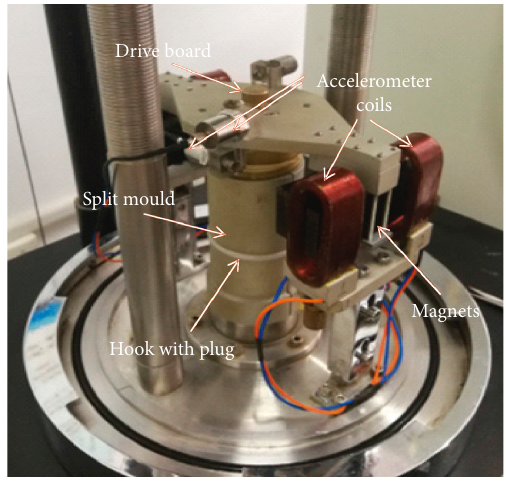
Figure 9: Photo of free-vibration column of